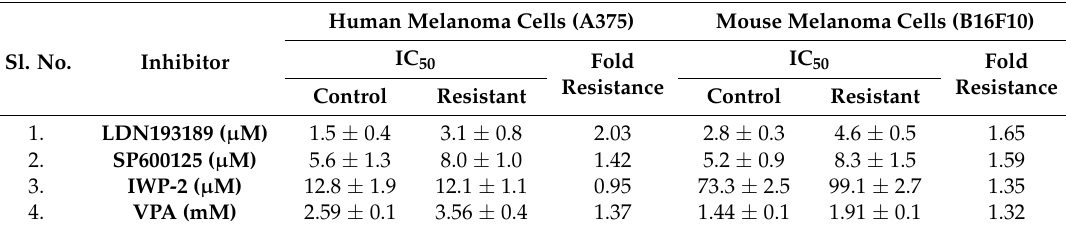
Table 1. Values and fold resistance of all the inhibitors used on A375 and B16F10 models.